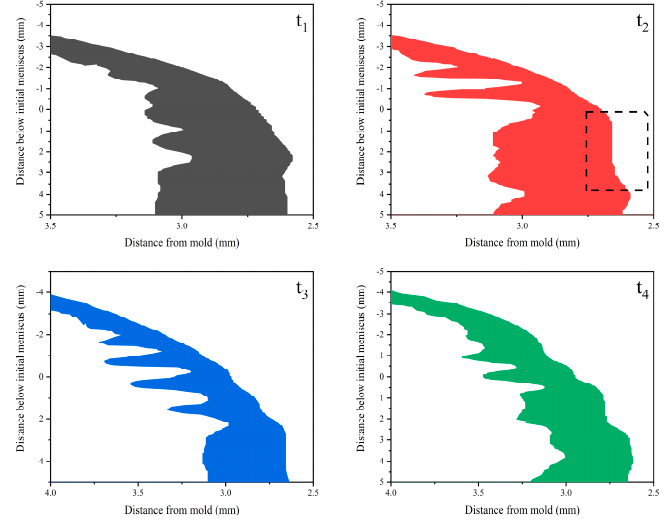
Figure 8. Evolution of shell profile during one cycle. Figure 9 exhibited pressure variation of the shell surface at different oscillating stages.